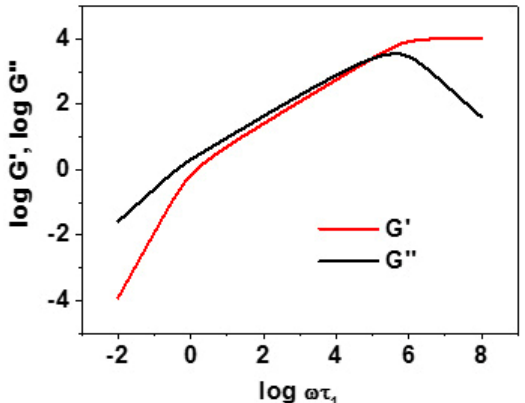
Figure 3. Plot of the real part G’ and the imaginary part G” of the viscoelastic complex modulus for a linear freely jointed chain with 10 4 repeat units. Here, the low-frequency behavior of Equation (5) can be clearly seen for ω τ 1 < 1, while at higher ω , the power-law behavior of Equation (6) can clearly be seen. Finally, at very high ω τ 1 (>10 6 for this linear chain), the results are not physically realistic, since G’ and G” would probe the intramolecular dynamics at length and time scales smaller that of a single spring.